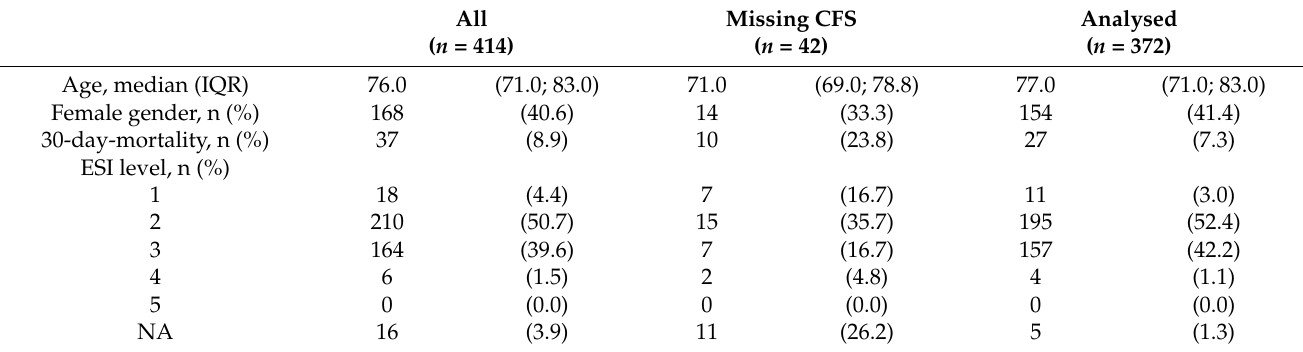
Table A1. Patient characteristics: All potentially eligible patients compared to patients with missing CFS and patients analysed.